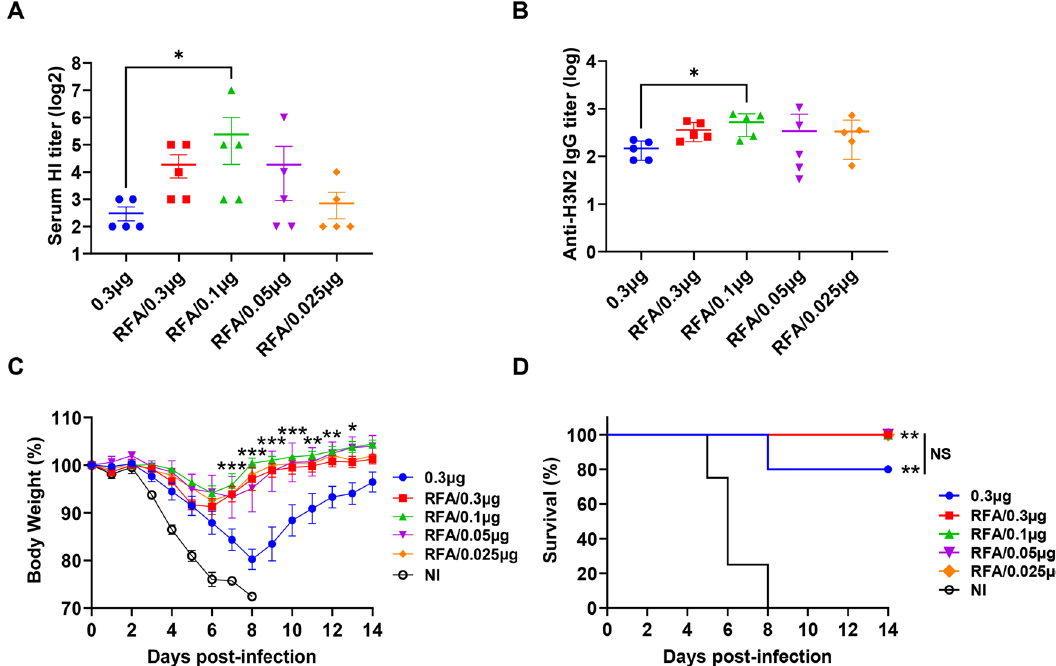
Figure 3. Dose-sparing effects of RFA in vaccine dose range (0.3–0.025 µg). BALB/c mice were intradermally injected with 0.3 µg H3N2 vaccine or subjected to RF treatment followed by ID injection of H3N2 vaccine of reducing doses (0.3–0.025 µg). Serum HI ( A ) and IgG titers ( B ) were measured three weeks later. Mice were challenged with 50 × LD50 of H3N2 viruses four weeks after immunization. Body weight change ( C ) and survival ( D ) were monitored daily for 14 days. n = 5. One-way ANOVA with Dunn’s multiple comparison test was used to compare differences among groups in ( A ) and ( B ). Two-way ANOVA with Dunnett’s multiple comparison test was used to compared differences between vaccine alone and RFA groups in ( C ). Log-rank test with Bonferroni correction was used to compare differences of survival between NI and other groups or otherwise specified in ( D ). *p < 0.05; **p < 0.01; ***p < 0.001. NS not